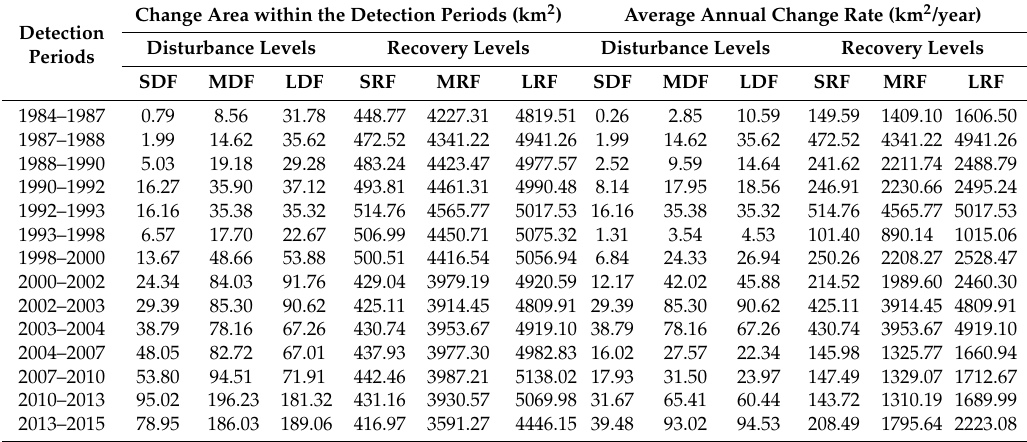
Table 5. A Summary of Statistical Data for Disturbance and Recovery Areas During Detection Periods.